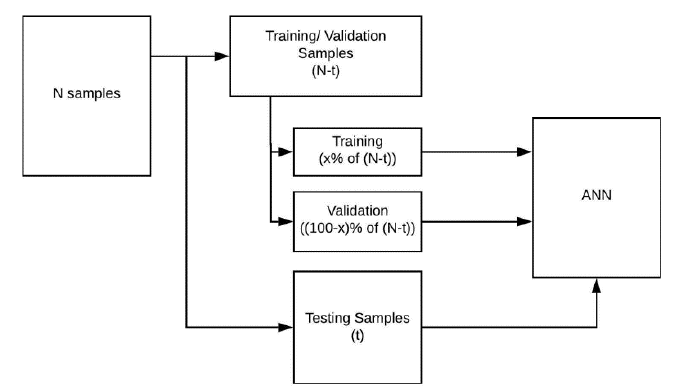
Figure 4. A schematic of the data organisation used in the ANN. In this study N = 102, representing all tested samples, and x varied between 50% and 90%.